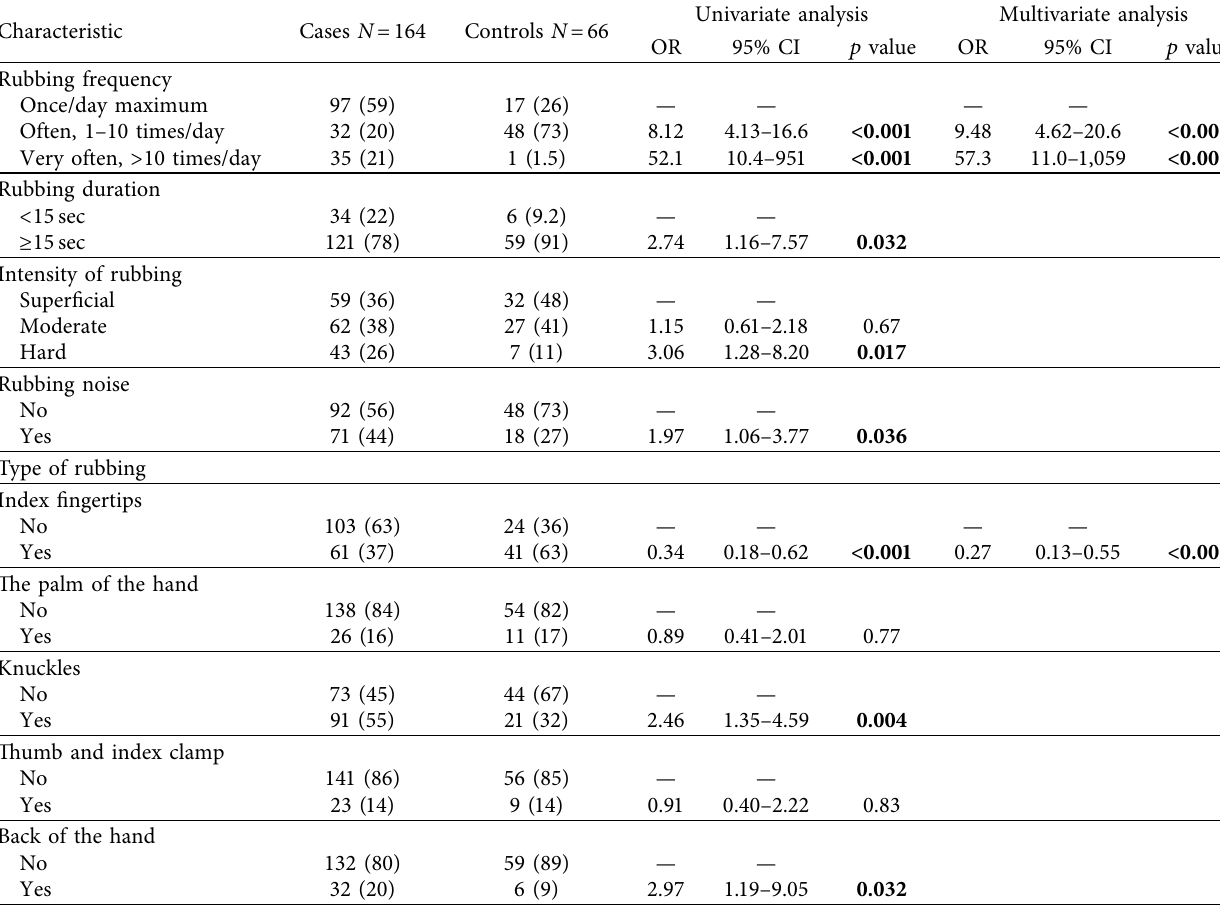
Table 4: Risk factors of keratoconus in the eye rubbing population and multivariate logistic regression.